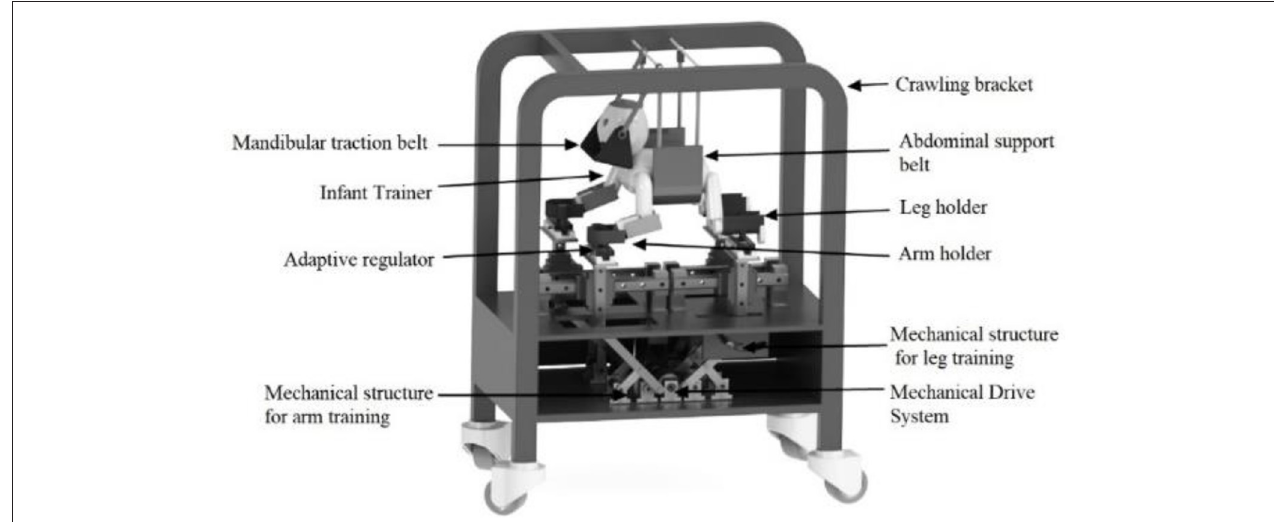
FIGURE 8 | Schematic diagram of crawling training device designed by Jiang et al.